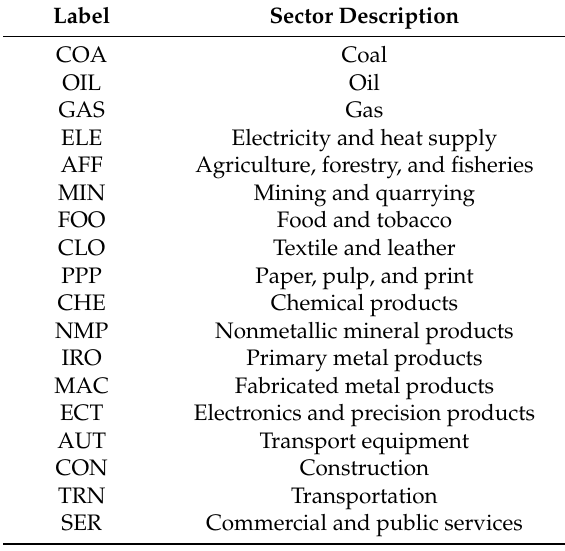
Table 1. Sector classification of the computable general equilibrium model in this study. Label Sector